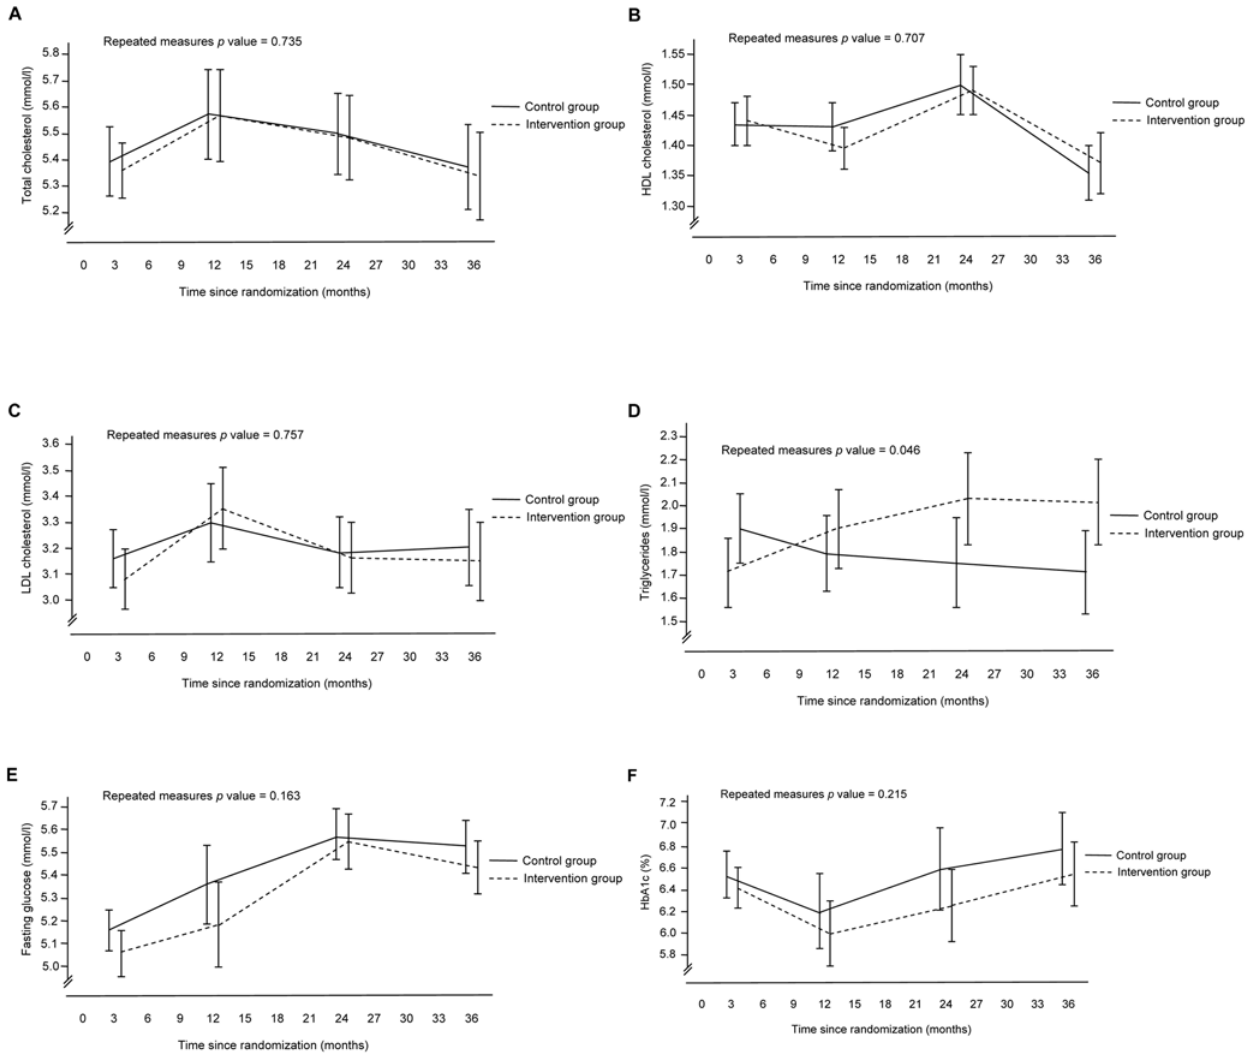
Figure 4. (A–F) Changes in laboratory characteristics. Data are adjusted means (95% confidence intervals) for each time point derived from generalised linear models with repeated measures. Adjustments are made for the baseline value for the respective outcome variable. Blood pressure values are also adjusted for medication load. Statistical significance at each follow-up time point generated from univariate analysis of variance, * p , 0.05, ** p , 0.01, *** p ,